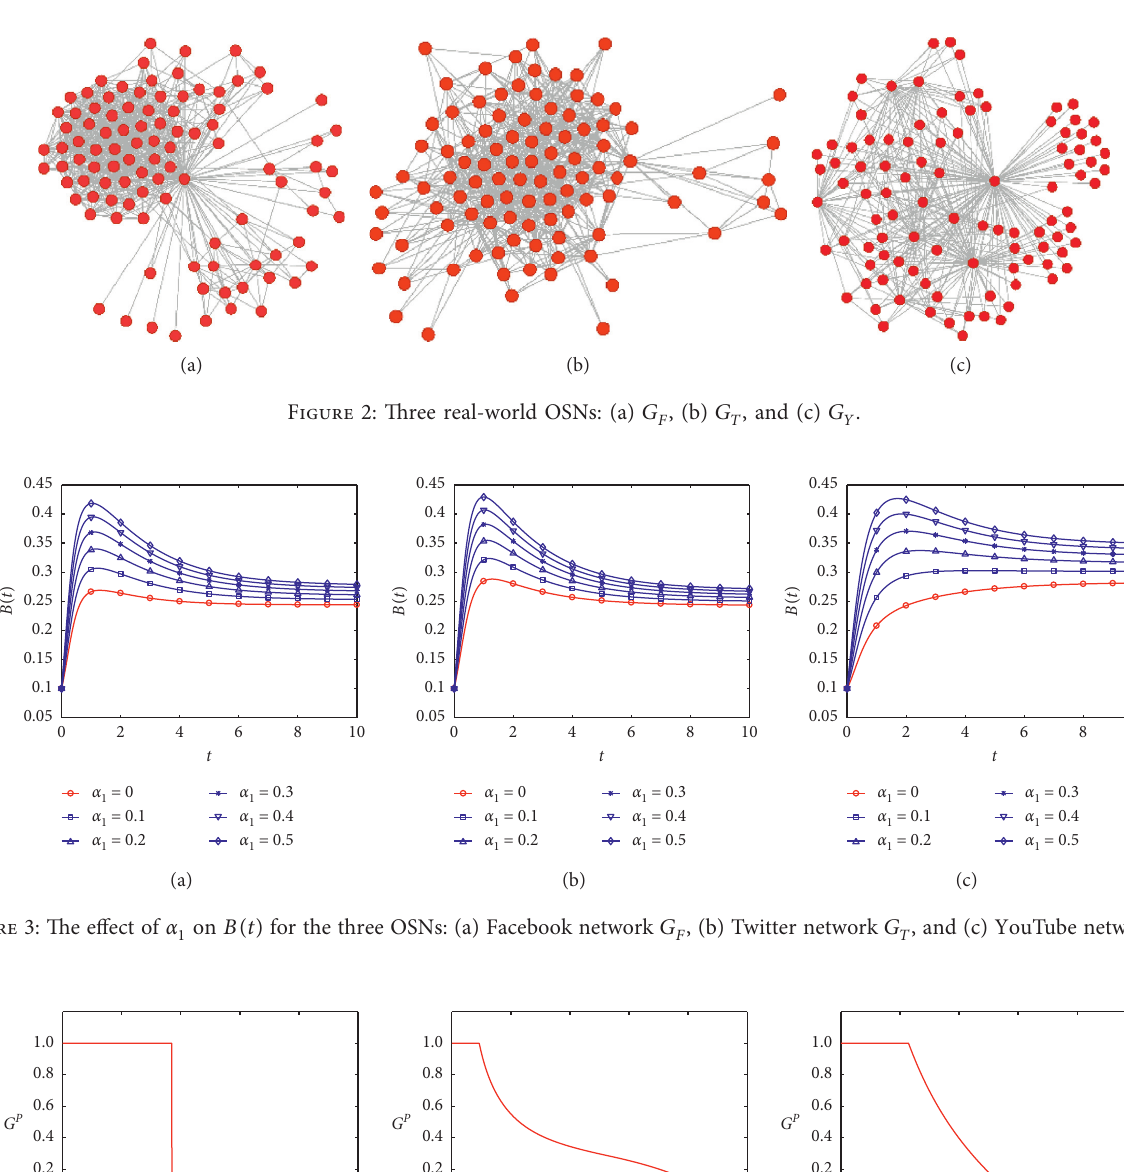
( x ) , θ ( x )) functions: (a) θ 1 2 ( x ) 2